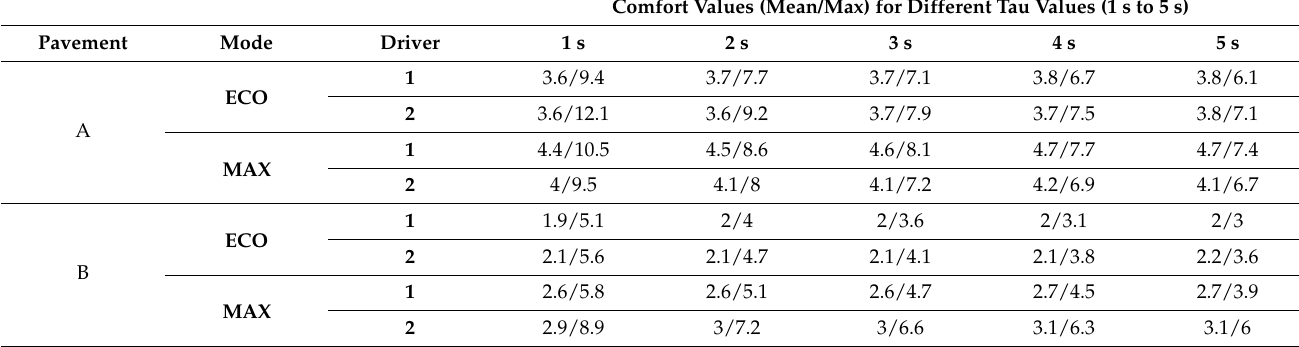
Table 5. Comfort values for RMS from 1 to 5